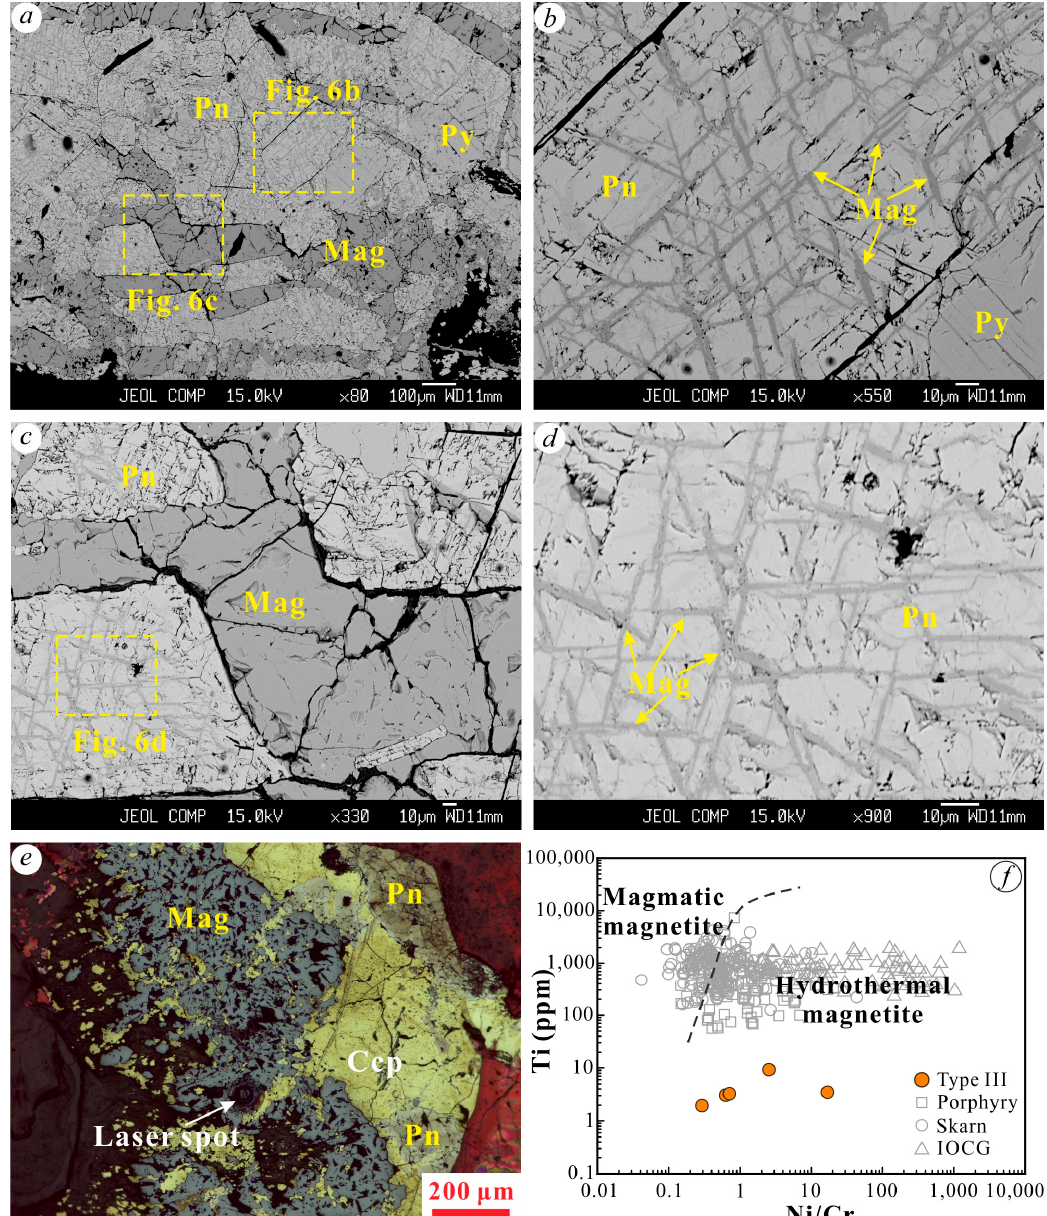
Figure 6. Diagrams showing hydrothermal-like affinity for the Jinchuan Type II and III magnetite in disseminated Cu-rich sulfide ores. ( a–d ) Type II magnetite infilled pentlandite along its cleavage. ( e ) Type III magnetite wrapped or replaced chalcopyrite. ( f ) Ti vs. Ni/Cr diagram (modified from [2]) showing magmatic and hydrothermal origin for magnetite. Hydrothermal magnetite data from porphyry (e.g., Yuleken), skarn (e.g., Tengtie, Tieshan, Baijian, and Fushan), and IOCG deposits (e.g., Lala) are from [13,15,20,49–51]. Note that the limited data for Type III and unpresented Type II magnetite with hydrothermal magnetite affinity in Figure 6f is due to the exclusion of some unbelievable Ni/Cr ratios and low detection limit of Ti in their geochemical data, with detailed geochemical data in Supplementary Material. Abbreviations: Ccp, chalcopyrite; Mag, magnetite; Pn, pentlandite; Po, pyrrhotite; Py, pyrite.